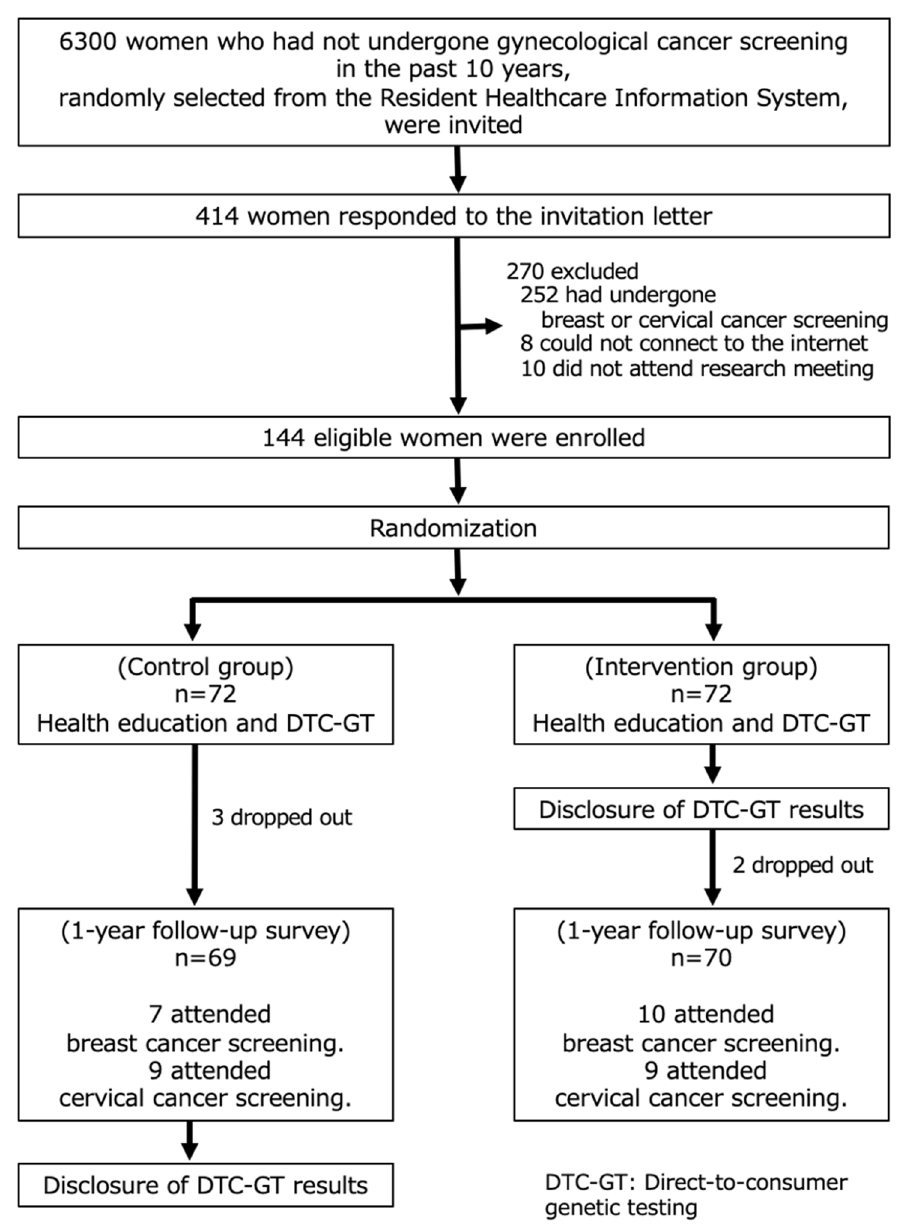
Figure 1. Study flowchart, in Okazaki, Japan, 2018–2019.